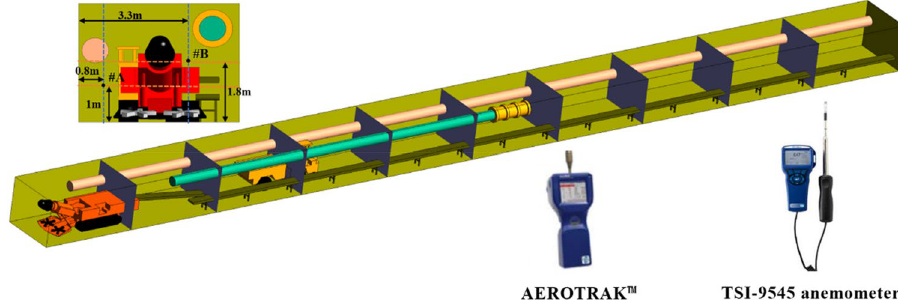
Figure 14. Layout of measuring